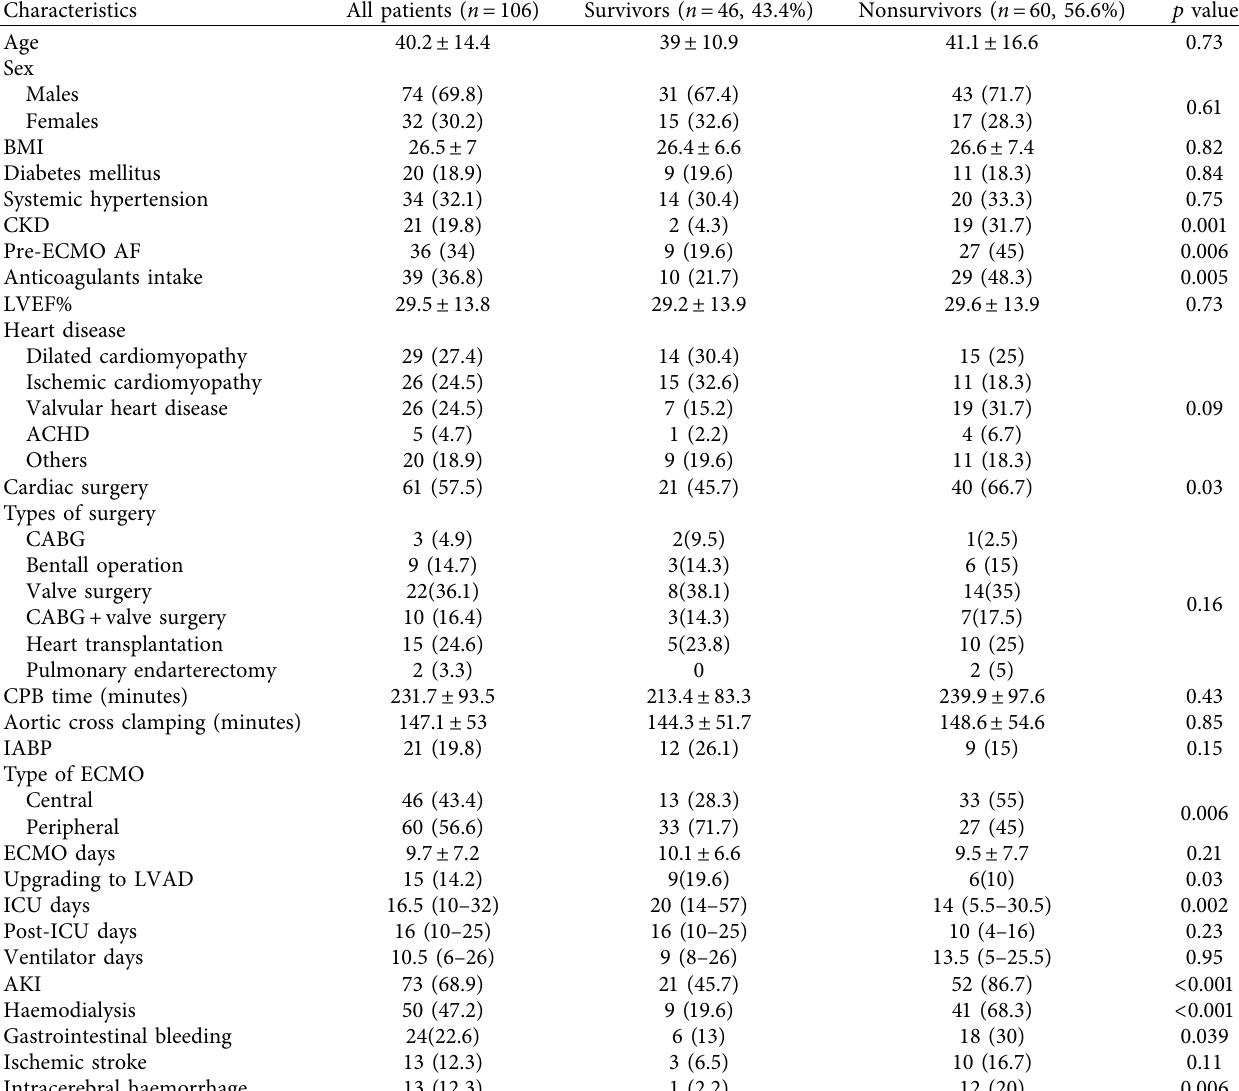
Table 2: Baseline characteristics of studied patients with VA-ECMO.